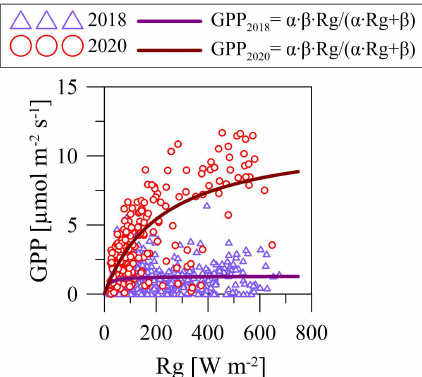
Figure 7. Hyperbolic light response curves (Eq. 3) of gross pri- mary production (GPP) for March 2018 and 2020 at the paludified forest